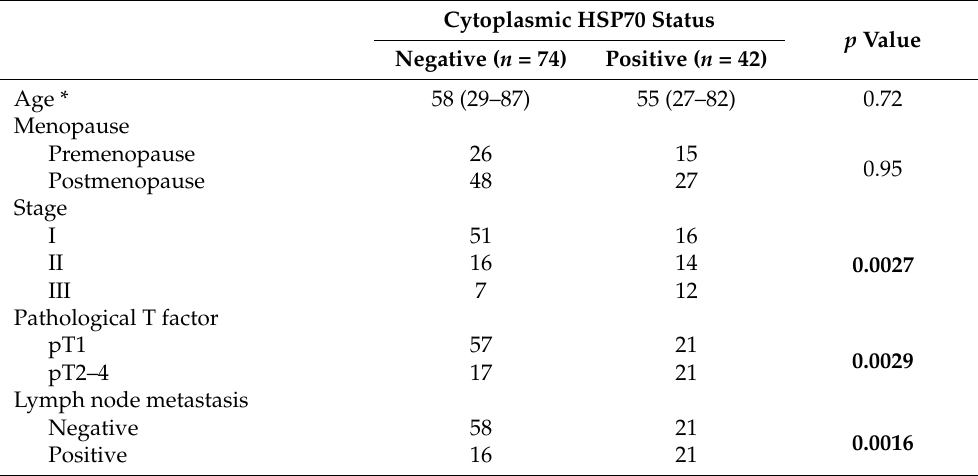
Figure 5. Immunohistochemistry for HSP70 in 116 breast carcinoma tissues. ( A – C ): Representative images of HSP70 immunostaining in the cytoplasm and nucleus of breast carcinoma cells (immunoreactivity of cytoplasm/nucleus = ( A ) positive/negative case; ( B ) negative/positive case; ( C ) positive/positive case). Bar = 100 µ m. ( D – I ): Disease-free survival ( D , F , H ) and breast-cancer-specific survival ( E , G , I ) curves according to cytoplasmic HSP70 immunoreactivity breast carcinoma cells ( D , E ) or a combination of cytoplasmic HSP70 immunoreactivity and macrophage infiltration ( F – I ) in all patients ( D – G ; n = 116) or in patients who had received adjuvant chemotherapy ( H , I ; n = 59). Table 1. Association between the immunoreactivity of HSP70 and clinicopathological parameters in 116 breast carcinomas.